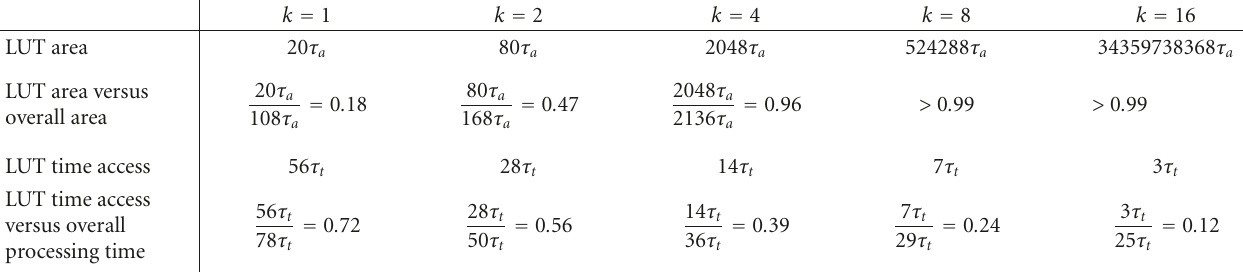
Table 6: Relationship between area, time delay, and fragment length k , for 16 bits data for processor